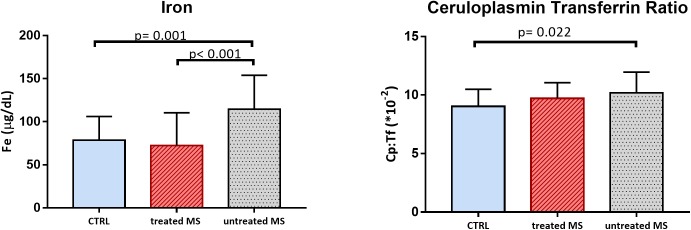
Bar plot (mean with SD) of iron (Fe) and ceruloplasmin transferrin ratio (Cp:Tf) in CTRL, MS in disease modifying therapy (treated MS), and in MS not in disease modifying therapy (untreated MS).